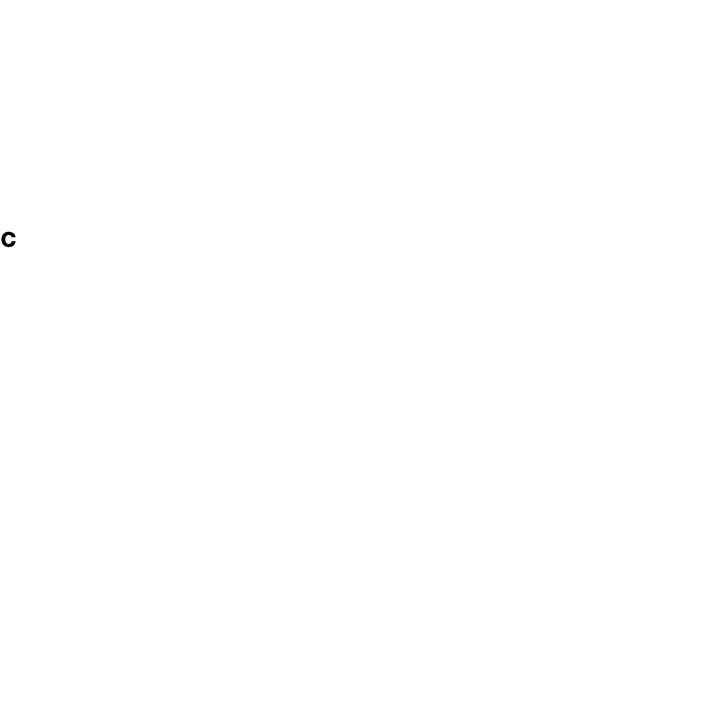
NexnG645Δ/G645Δ mice display progressive dilated cardiomyopathy.(A) Schematic representation of Nexn genetic sequence, with glycine in position 645 (G645, equivalent to the human G650). (B) Schematic representation of CRISPR/CAS9 deletion strategy. (C) Representative PCR from a control (NexnWT/WT) mouse and mice homozygous (hom) (NexnG645Δ/G645Δ) or heterozygous (het) for the G645 deletion. (D and E) Representative sequencing of (D) a control and (E) a NexnG645Δ/G645Δ mouse. (F) Representative whole-heart H&E- and Masson’s trichrome–stained images, 4-chamber views, of longitudinal histological sections from NexnWT/WT and NexnG645Δ/G645Δ mice at P10 and 3 months (3M) of age. Scale bars: 1 mm.